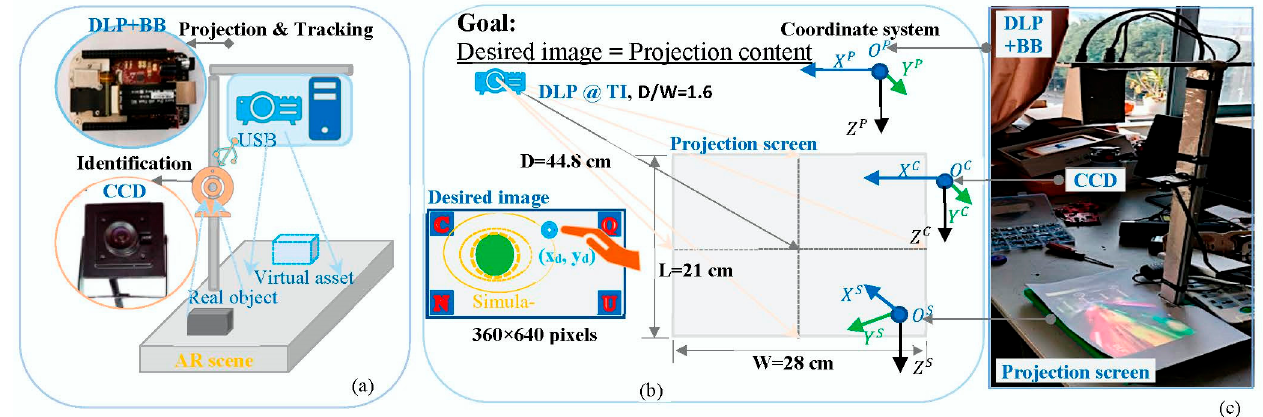
Figure 1. The configuration of the proposed AR experimental platform consisting of a digital light processing (DLP), Beaglebone Black (BB), and CCD modules: ( a ) schematic diagram for illustrating identification, projection, and tracking; ( b ) geometric parameter of the setup, where the DLP with a distance/width (D/W) ratio of 1.6 is configured at the projection distance (D) of 44.8 cm; ( c ) an image of the prototype with three coordinate systems of projector, camera, and real world, {OP, OC, OS}.